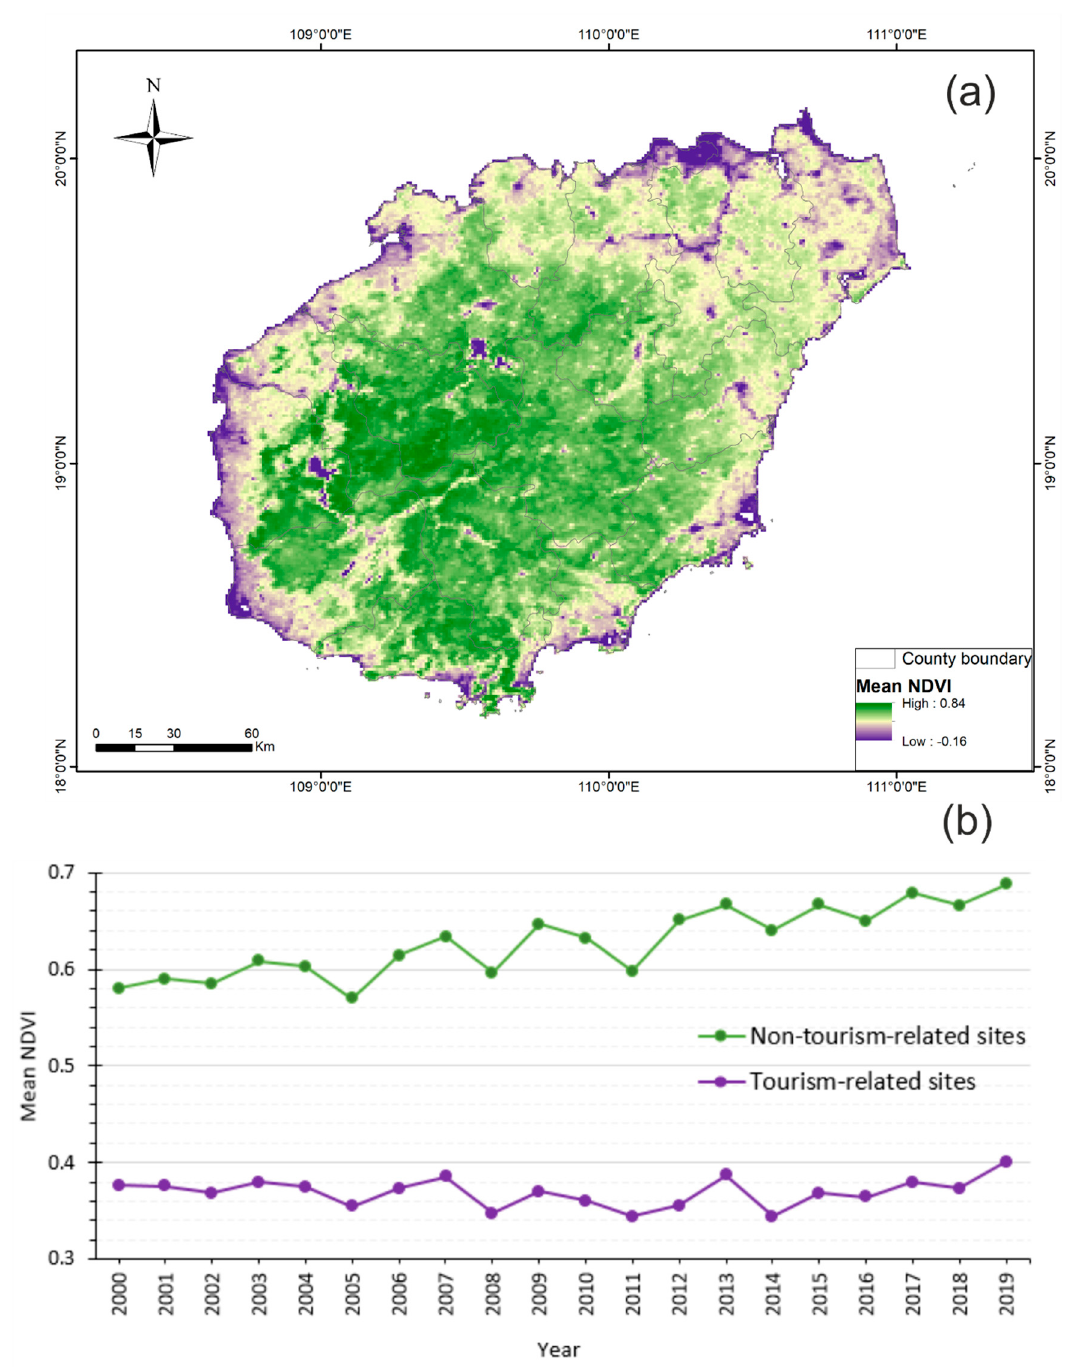
Figure 10. Normalized Difference Vegetation Index (NDVI) variations from 2000 to 2019 (( a )-The long-term mean NDVI variation; ( b )-The annual mean NDVI variation).